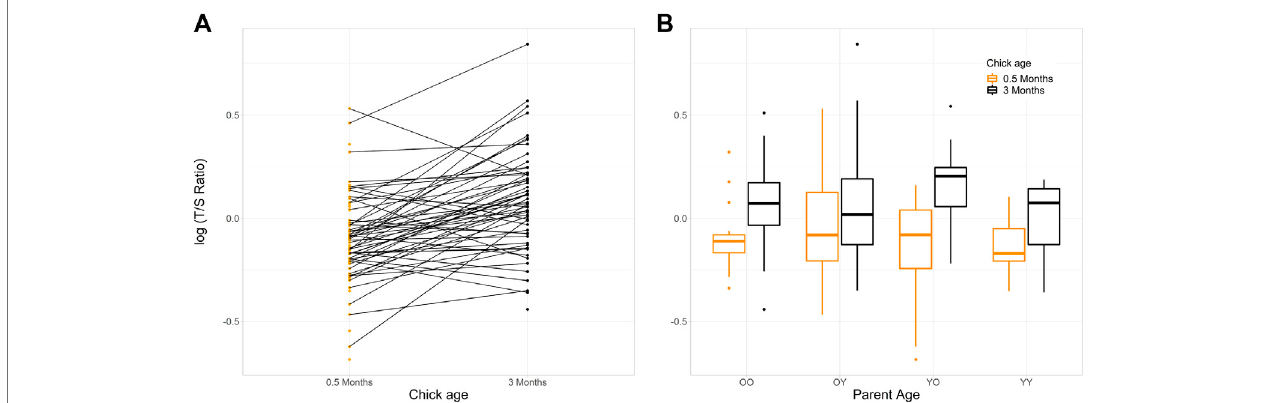
FIGURE 1 | Change in telomere length log (T/S Ratio), within house sparrow chicks at 0.5 and 3 months of age. (A) Individuals are connected by a line (n offspring withsamplesat0.5 months=75,at3 months=59). (B) Boxplots showthemean(centralline)and25thand75thpercentiles (lowerandupperboxbounds respectively) of the log (T/S Ratio) within age group of the chicks ’ parents (young birds, Y, were a parents that hatched the preceding summer, old birds, O, were parents that were ≥ 4 years old). T/S Ratio is presented on the log scale to aid visualisation. YO = young mothers, old fathers ( n = 19 offspring with 0.5 months samples, 12 offspring with 3 months samples). OO = both parents old ( n = 18, 19). OY = old mothers, young fathers ( n = 17, 18). YY = both parents young ( n = 15, 10).